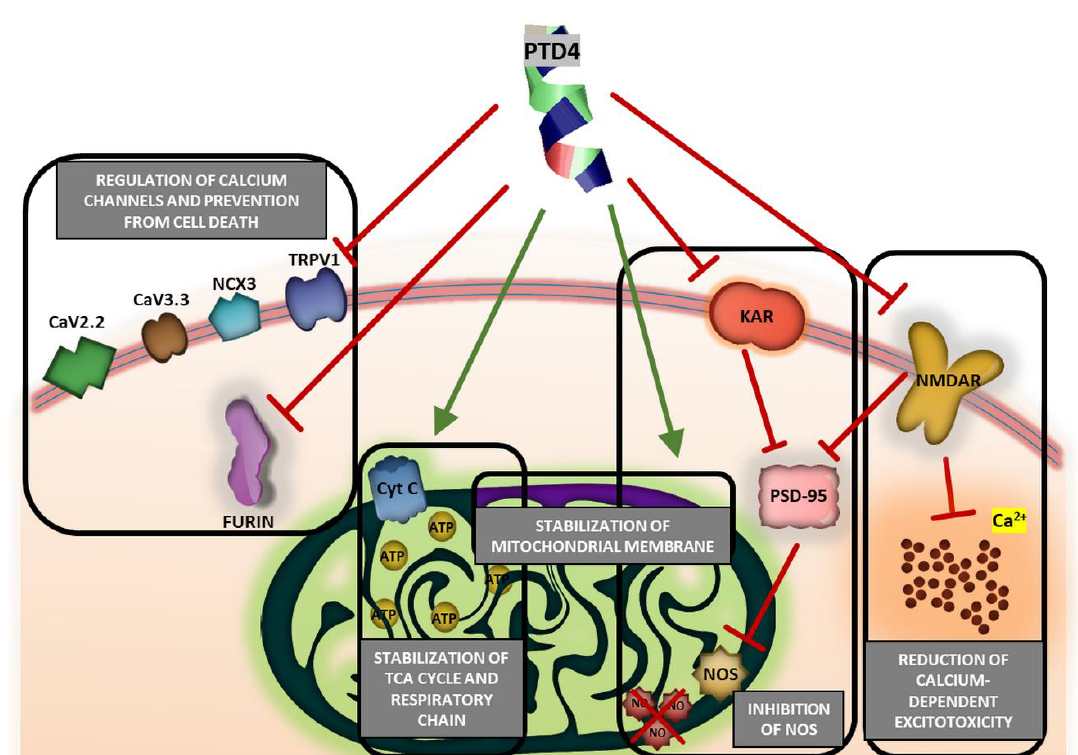
Figure 8. Conjectured mechanisms of PTD4-mediated neuroprotection based on the results of the study. PTD4– Y 47 ARAAARQARA 57 -amide; CaV2.2–N-type voltage-gated calcium channel; CaV3.3–T-type voltage-gated calcium channel; NCX3–sodium-calcium exchanger 3; TRPV1–transient receptor potential cation channel subfamily V member 1; Cyt C– cytochrome C; ATP–adenosine triphosphate; NOS–nitric oxide synthase; NO–nitric oxide; PSD-95–post-synaptic density protein 95; KAR–kainic acid receptor; NMDAR–N-methyl-D-aspartic acid receptor; TCA–tricarboxylic acid cycle.